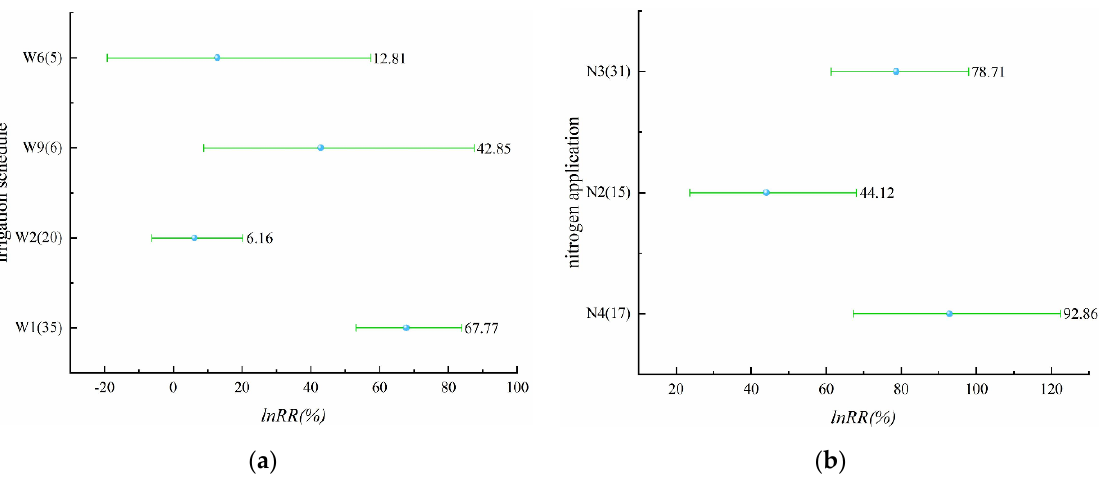
Figure 5. ( a ) Effect of different irrigation schedules on N 2 O emissions ( p = 0.00004); ( b ) effect of different nitrogen application levels on N 2 O emissions ( p = 0.00538).